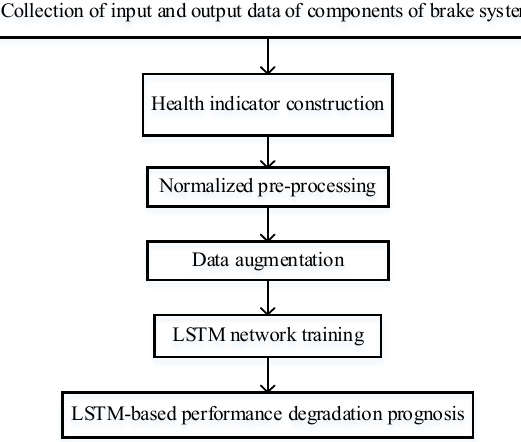
Figure 3. Prognosis flowchart.